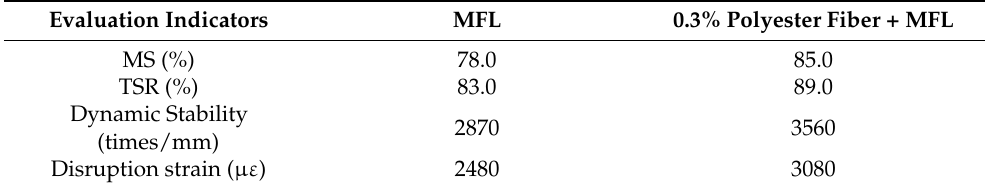
Table 5. Performance improvement of Polyester fiber on salt storage asphalt